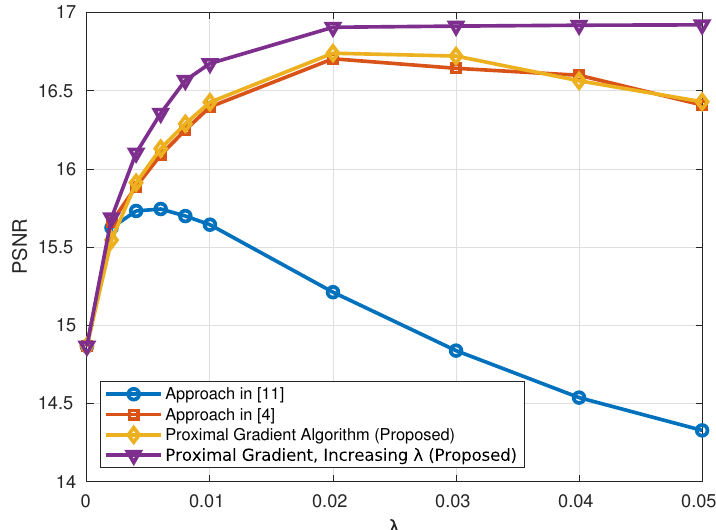
Figure 4. PSNR values for various algorithms as a function of the parameter λ , for q =